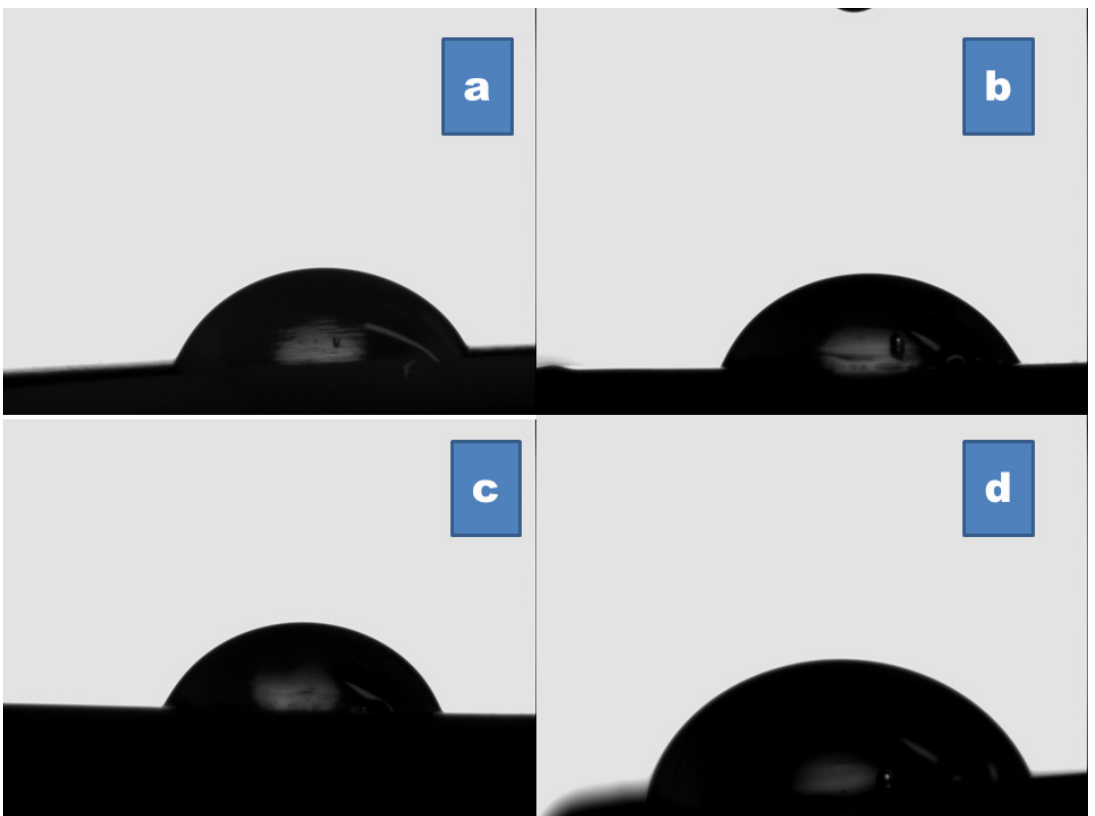
Fig. 7. Images of the contact angle of milli-Q water on the surface of pure APE (a) and the APE/TiO (c) and 5% TiO 2